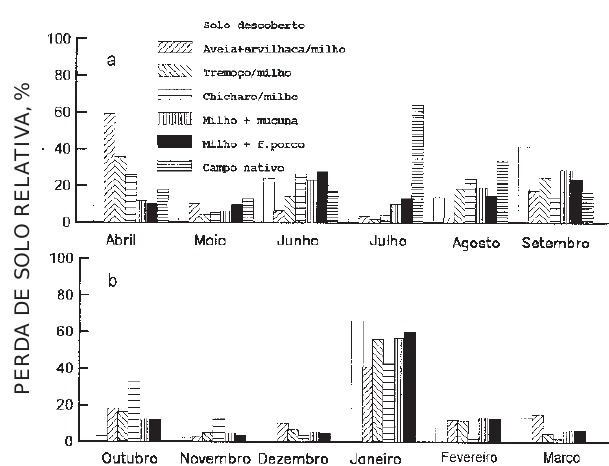
Figura 2. Distribuição da perda de solo relativa mensal, nos sistemas de produção de milho, de abril/92 a